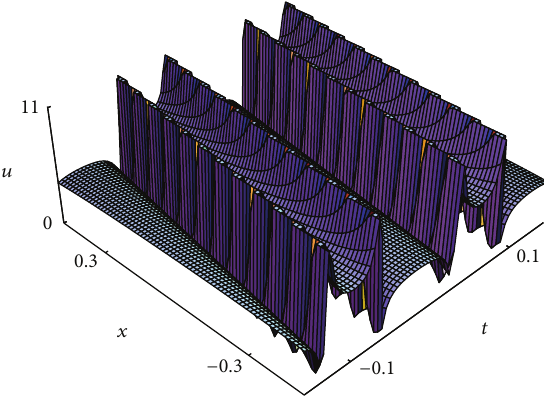
Figure 5: Evolution of the solutions of (32). Periodic wave solution: parameters are 𝛼 = 1 , 𝛽 = 1 , 𝑎 1 = 5 , and 𝐾 = −2